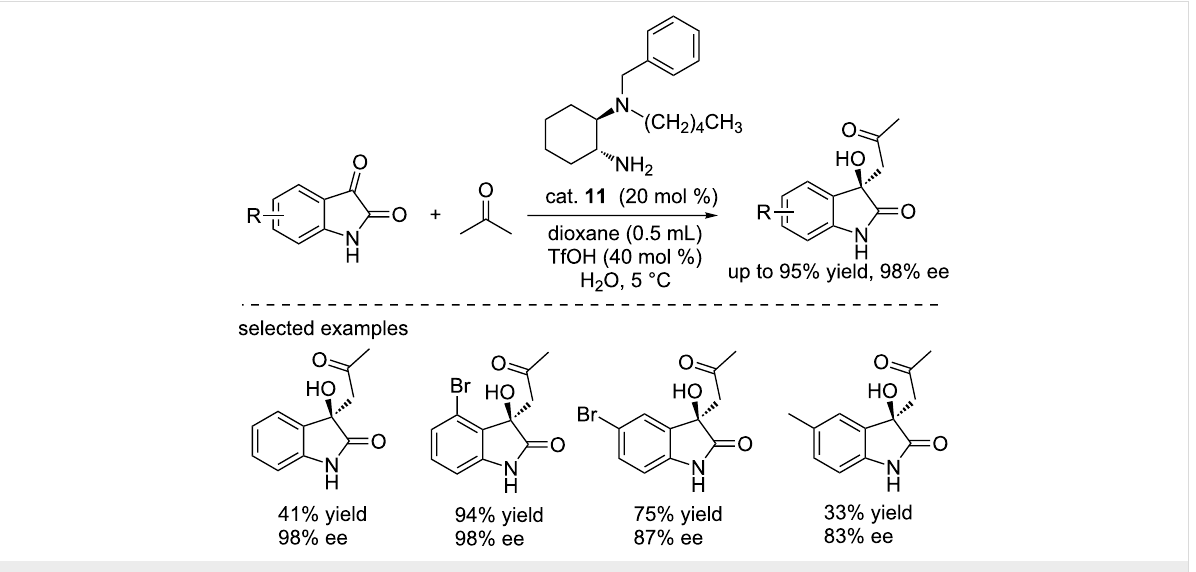
Scheme 25: Aldol reactions of acetone with